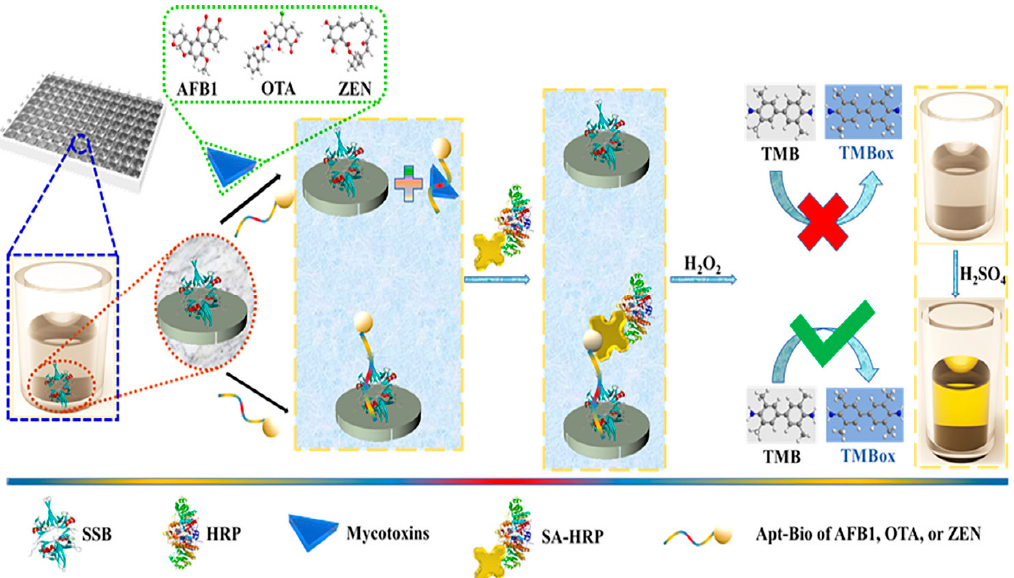
Figure 13. Schematic diagram for synthesis of green ELISA based on SSB-assisted aptamer and step-by-step detection of mycotoxins using the ELISA-based SSB-assisted aptamer. It shows that when there were target mycotoxins present, the aptamer − biotin could not bind to the SSB in presence of mycotoxins, which resulted in weak yellow color of solution. Reproduced from [111].